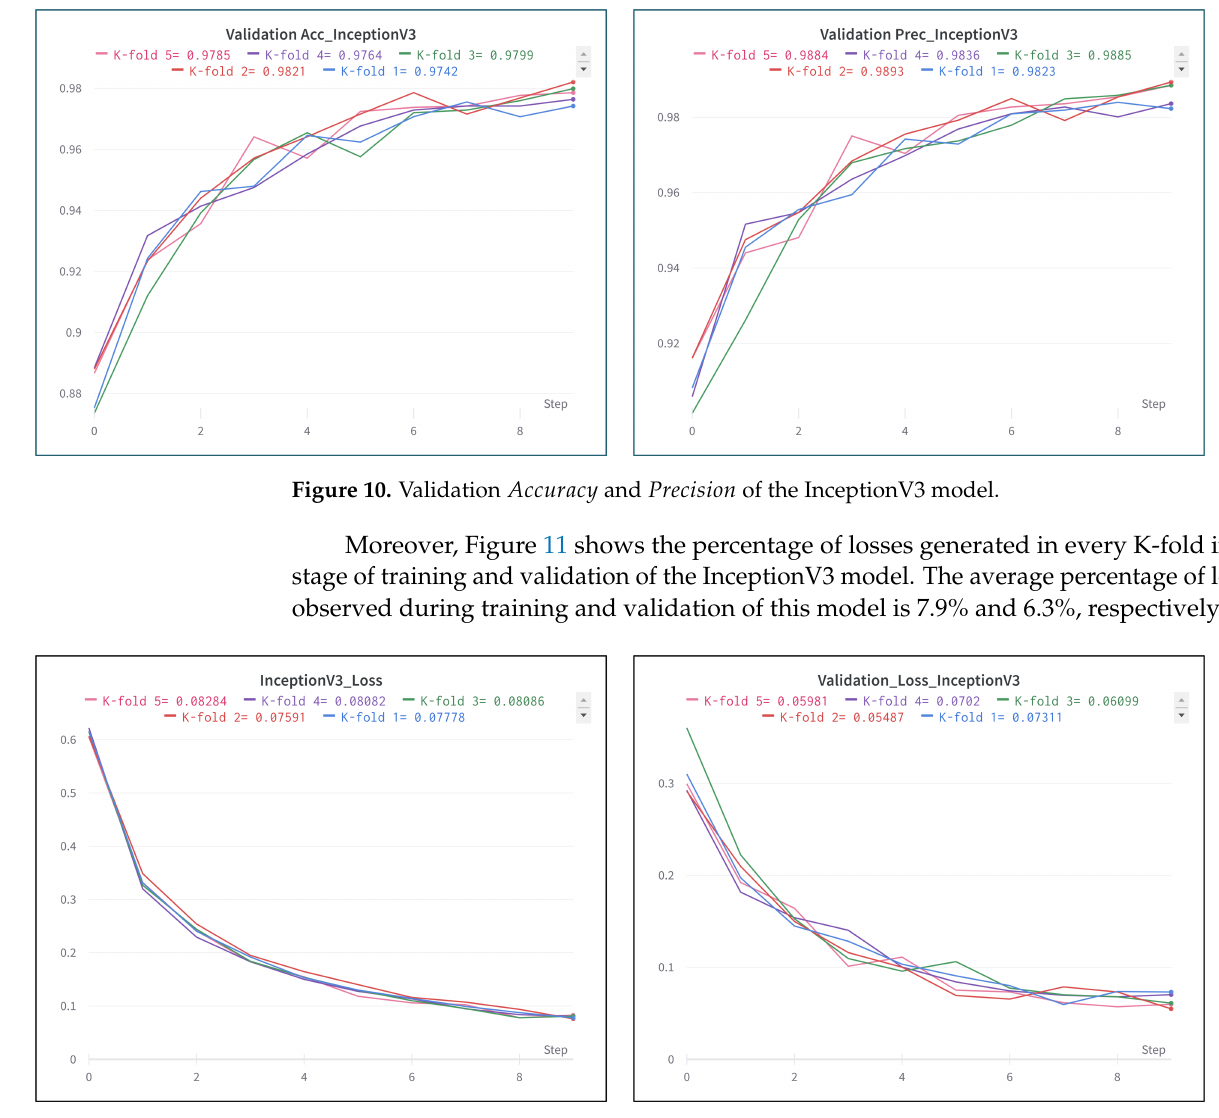
Figure 11. Training loss and validation loss of the InceptionV3